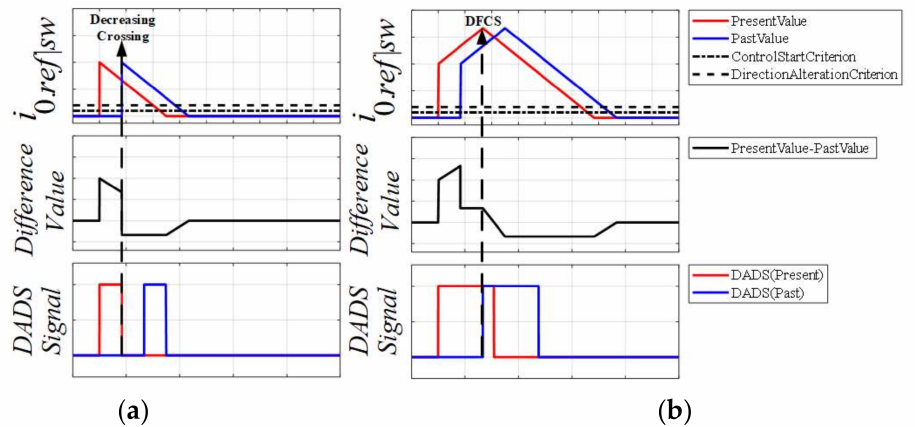
Figure 5. The conceptual trend of ZSCC present value and past value and the difference between these values after abrupt disturbance, determining the validity of the compensation direction and determining whether to change the direction. ( a ) when compensating with the correct direction, ( b ) when compensating with the incorrect